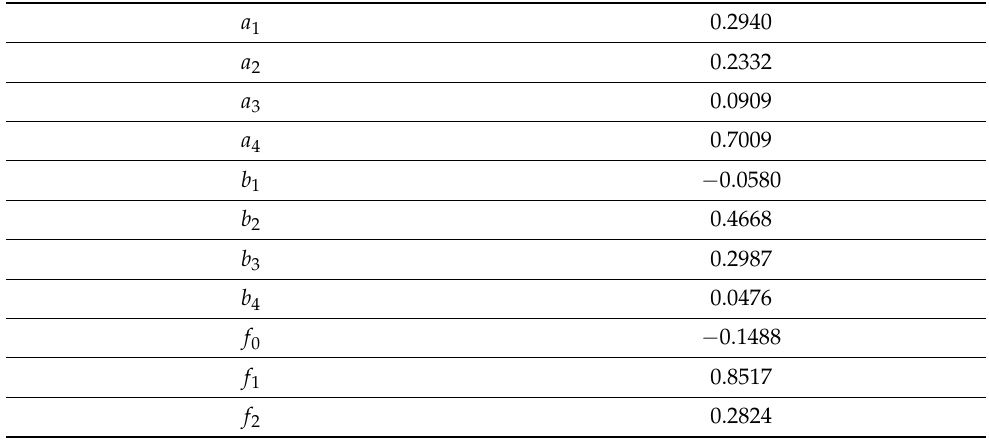
Table A1. Set of coefficients used for the s T dynamic function for